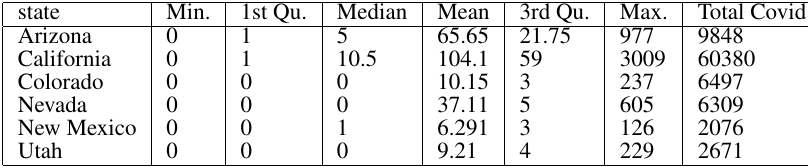
Table 5. Covid-19 Infected Cases in summer.